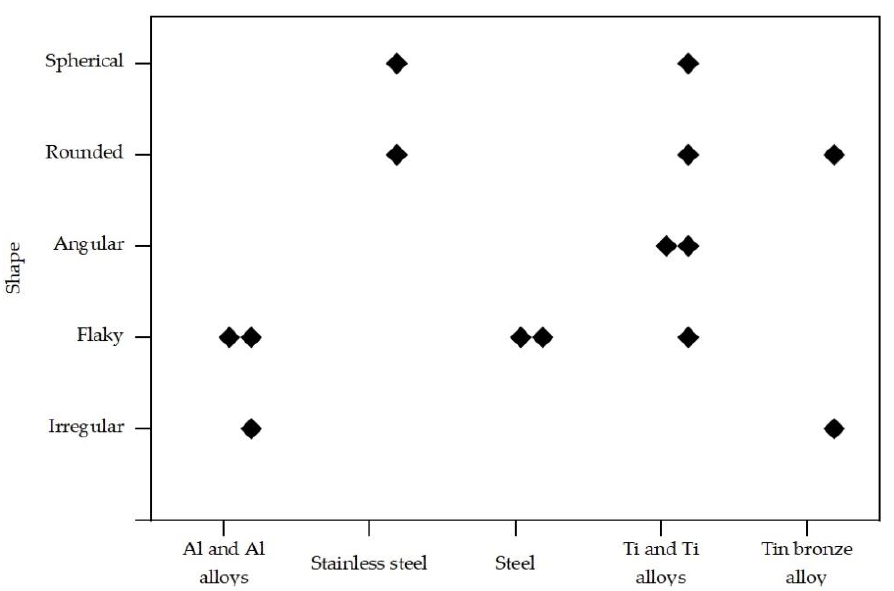
Figure 2. Illustration of particle shape mentioned in Table 3 (diamond inserts in this graph represent studies discussed in this review article, as cited in Table 3). studies discussed in this review article, as cited in Table